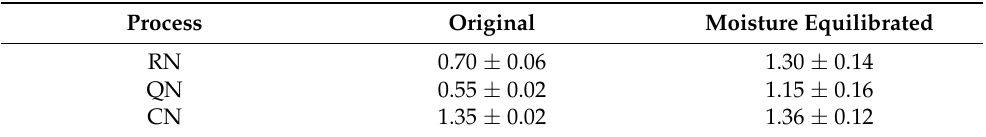
Table 4. Comparison of residual moisture levels of the original and moisture equilibrated